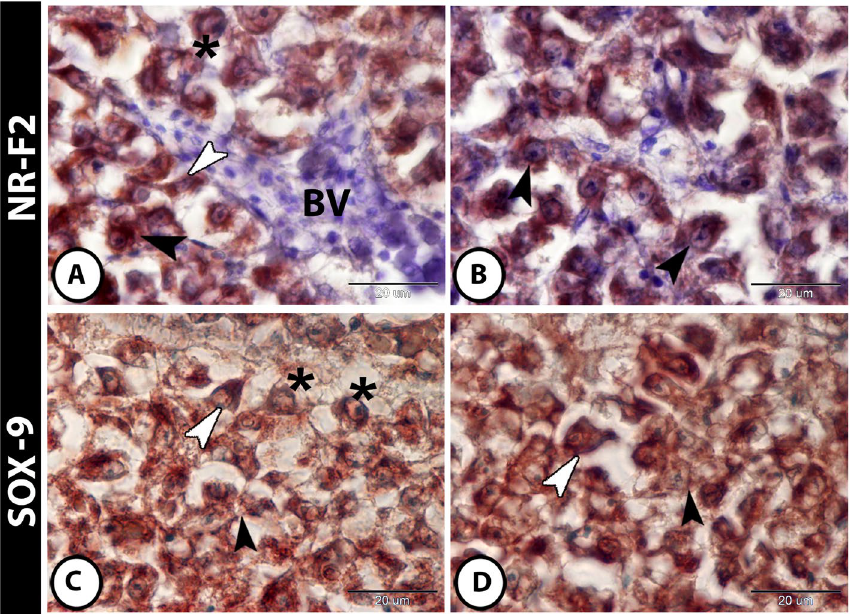
Fig. 5 Expressions of Nrf2 and SOX9 in liver of molly fish. A and B The hepatocytes expressed Nrf2 strongly (black arrowheads). Telocytes (white arrowheads) and stem cells (asterisks) expressed NR-F2 strongly too. C and D SOX9 showed immunoreactivity in hepatocytes (black arrowheads), in stem cells (asterisks), and in macrophages (white